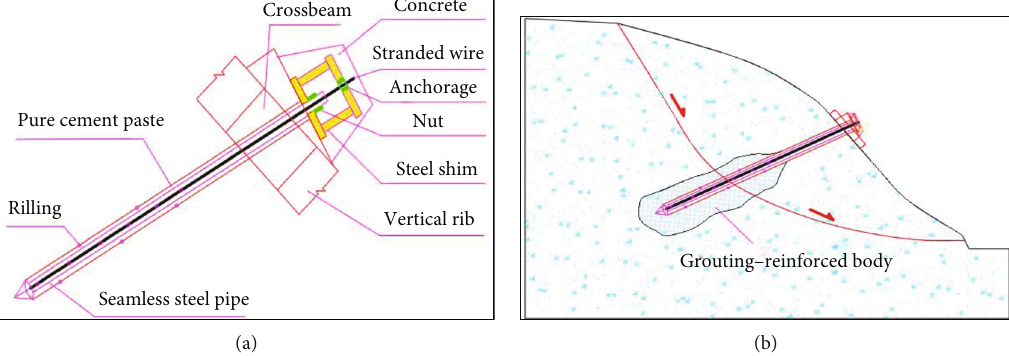
Figure 2: Structure and reinforcement mechanism of prestressed steel anchor tube frame beam. (a) Prestressed grouted steel anchor